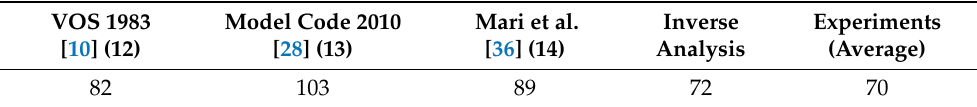
Table 9. Load capacity [kN] of small reinforced concrete beam without transverse